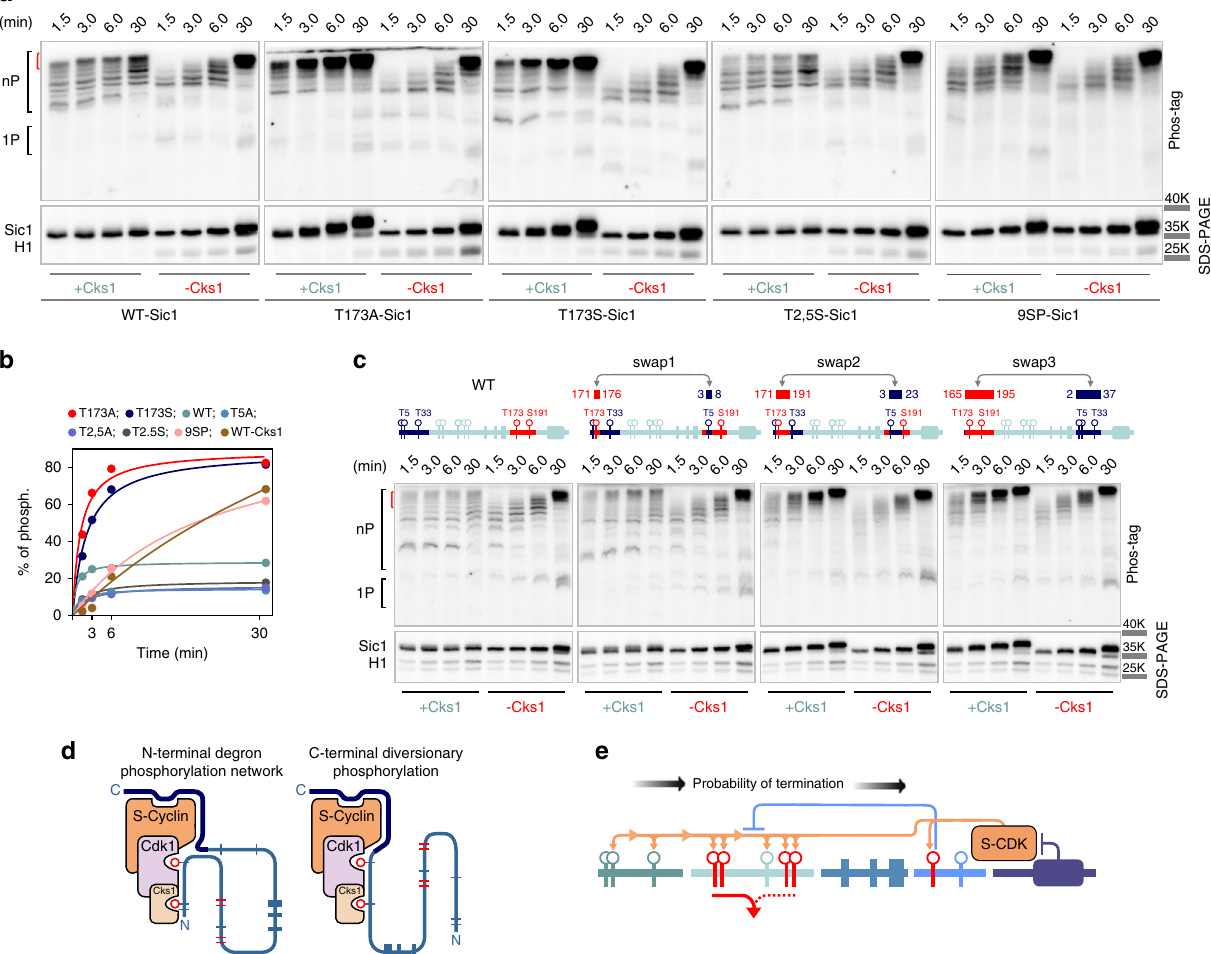
Fig. 2 The intracomplex phosphorylation of N-terminal multisite phosphorylation network of Sic1. a The intracomplex phosphorylation of different Sic1 phosphorylation site mutants by Clb5 – Cdk1 were followed in the presence or absence of the phospho-adaptor protein Cks1. The 9SP-Sic1 denotes a mutated form where all TP phosphorylation sites were mutated to SP. The upper gels contained Phos-tag to resolve phosphorylated forms. The control incubations shown in the lower panels are ordinary SDS – PAGE and also contain the external substrate Histone H1. b Quanti fi ed time courses of the hyperphosphorylated forms from the assays shown in a . The quanti fi ed segment is indicated by red bracket on the left in the a . The 100% phosphorylation corresponds to total radioactivity quanti fi ed from all phospho-bands of the corresponding lane. c Three different versions of Sic1 with swapped regions around Cdk1 sites T5 and T173, as indicated on the schemes, were analyzed using Phos-tag kinase assay as in a . The experiments for a and c were performed twice with similar result. d Two alternative and mutually competitive phosphorylation modes of Sic1 within the inhibitory complex. S-CDK phosphorylates Sic1 within the inhibitory complex, targeting both N- and C-terminal sites. In case phosphorylated T173 binds to the Cks1 pocket, the N-terminal phosphorylation process is terminated. e Schematic depiction of intracomplex phosphorylation steps and increasing probability of their termination by diversionary phosphorylation. The full gel radiographs are presented in Supplementary Fig. 7. Source data are provided as a Source Data fi